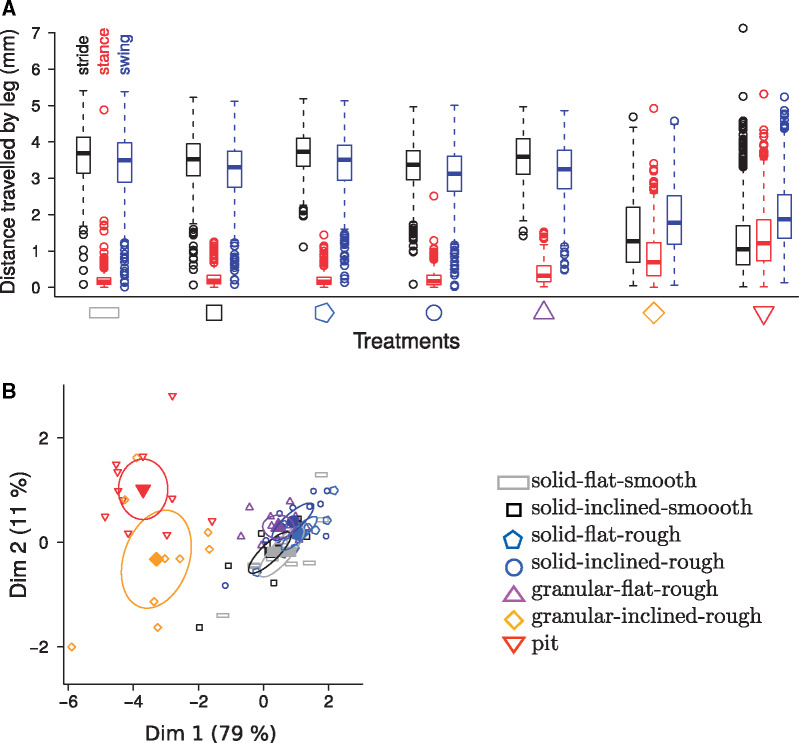
Leg kinematics and distance traveled in the world frame. A) Distance traveled by legs during a stride (black, left), a stance phase (red, center), and swing phase (blue, right) as function of the treatment. Each boxplot shows the distances of all strides of the six legs of all ants for the corresponding treatment. Two points are outside the window. B) Principal component analysis of leg kinematics in the factorial design experiments. Individuals are ants (open symbols) and the variables are the speed and five leg variables. The closed symbols are the means of the seven treatments. Ellipses indicate the 95% confidence intervals of the means. The six variables are all well represented using the first two axes and represent between 86% and 94% of inertia, depending on the variable.